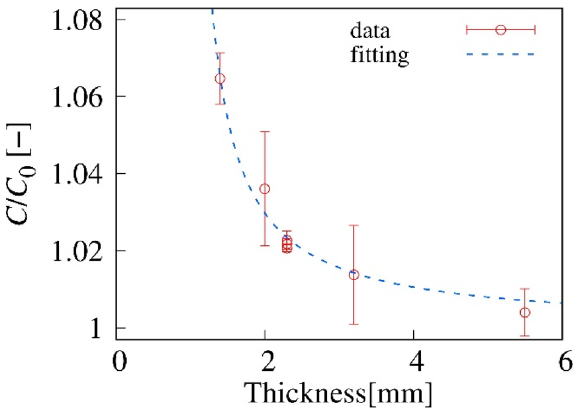
Figure 5. Dependence of the capacitance of Galinstan on the PDMS thickness. Red and blue markers indicate the experimental results measured by uniform electrodes and the maximum change estimated from the results shown in Fig. 4(c), respectively. The diameter of the channel is 1 mm. The green line is the best fit curve obtained using Eq. (5a).